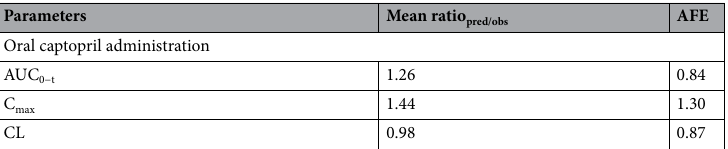
Table 3. Mean ratio pred/obs and average fold error (AFE) values of captopril PK parameters in pediatrics population after oral administration.